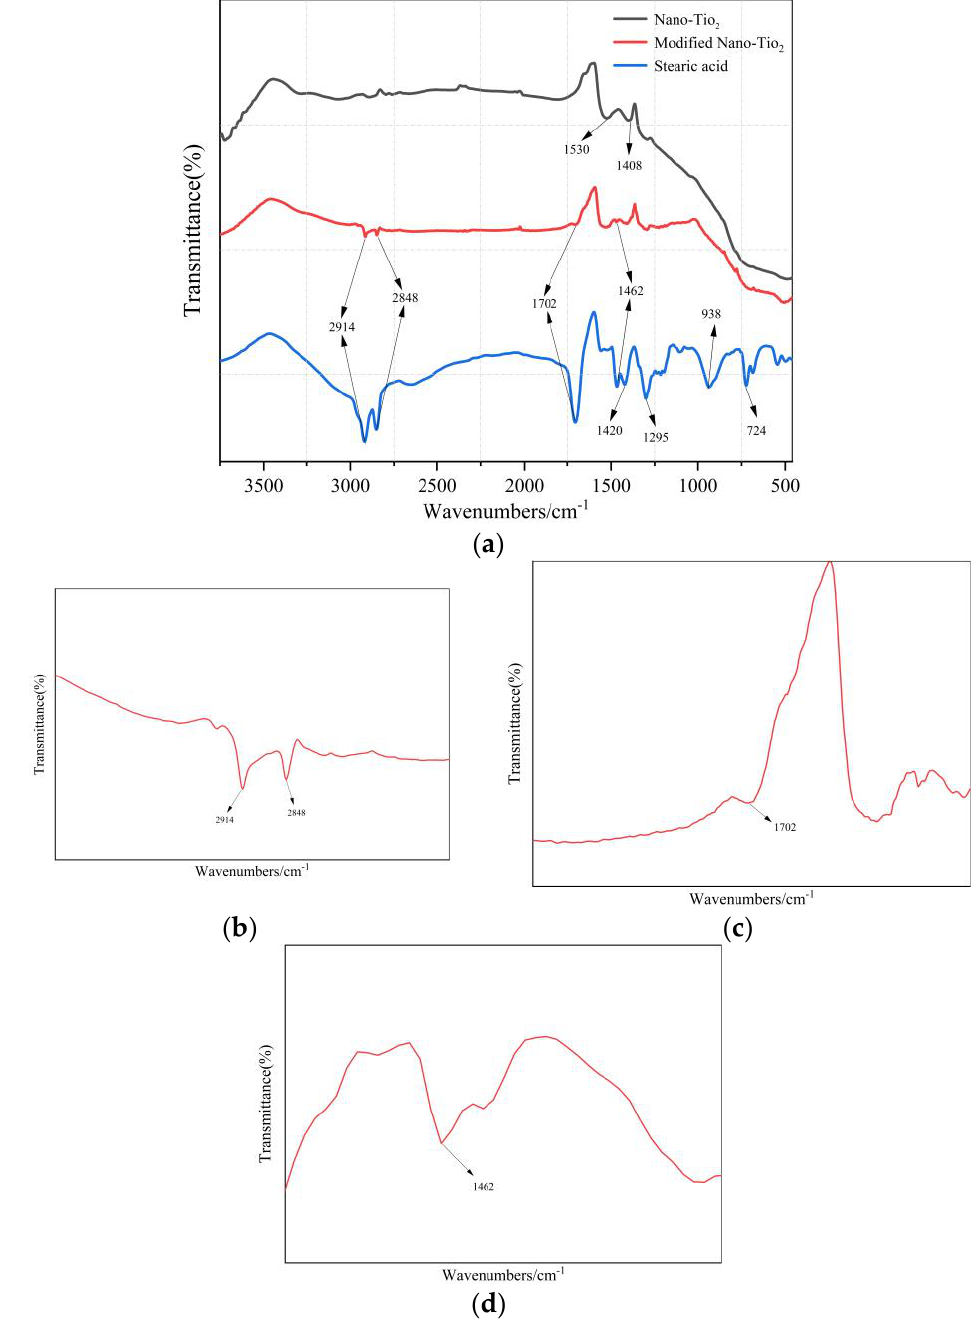
Figure 5. Fourier transform infrared spectroscopy curves: ( a ) Fourier transform infrared spectrum curves of stearic acid and nano-TiO 2 before and after modification; ( b – d ) a magnified view of the wavenumber range of characteristic peaks.